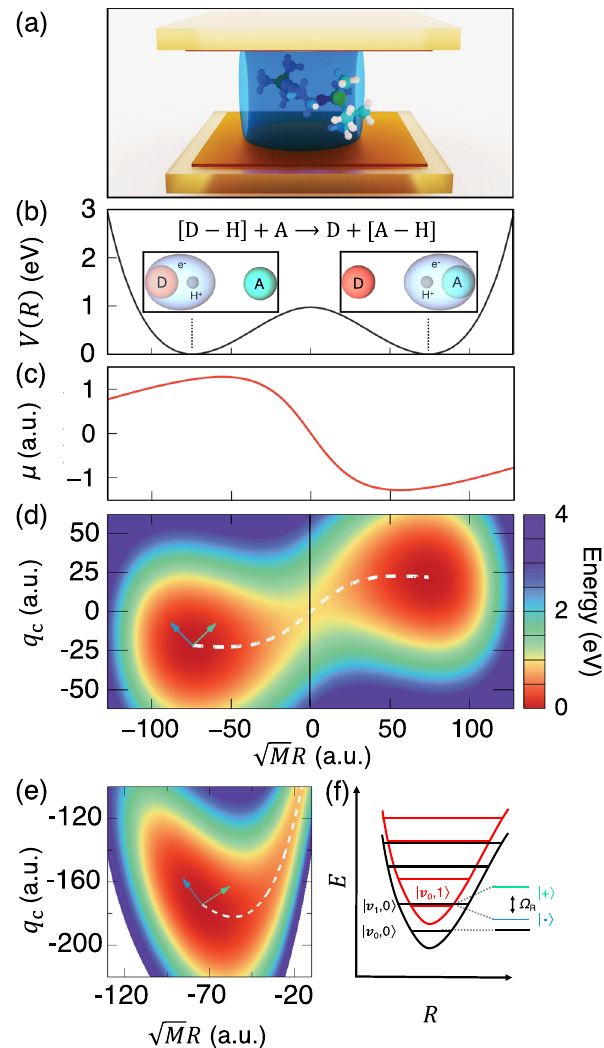
Fig. 1 Vibrational strong coupling (VSC) regime in polariton chemistry. a Schematic representation of a molecule placed inside an optical cavity. b Proton-coupled electron transfer reaction of a Shin – Metiu model. Ground- state potential energy surface (PES) of the molecule as a function of the ffiffiffiffiffi p M R (in atomic unit) for the Shin – Metiu mass-weighted proton coordinate molecular model system. The ground-state electronic density at two different nuclear con fi gurations (at the donor and acceptor minima) are illustrated in the insets. c Ground-state permanent dipole (solid red line) as ffiffiffiffiffi p M R . d Cavity a function of the mass-weighted proton coordinate Born – Oppenheimer (CBO) surface along photonic coordinates q c and mass- ffiffiffiffiffi p M R , with the white dash line representing weighted reaction coordinate the minimum energy path at the resonant frequency ℏ ω 0 = ℏ ω c = 0.1706 eV and with a coupling strength η = 0.047. e A zoom-in to the reactant well of the CBO surface at the resonant frequency ℏ ω c = 0.1706 eV and η = 0.376. The arrows in d and e represent the directions of two polariton normal modes. f Schematic diagram showing the Rabi splitting ℏ Ω R due to the light-matter coupling between photon-dressed vibronic-Fock states, (cid:3) (cid:3) (cid:4) (cid:4) (cid:3) (cid:3) ν ; 1 (photonic excitation) and ν 1 ; 0 (vibrational 0